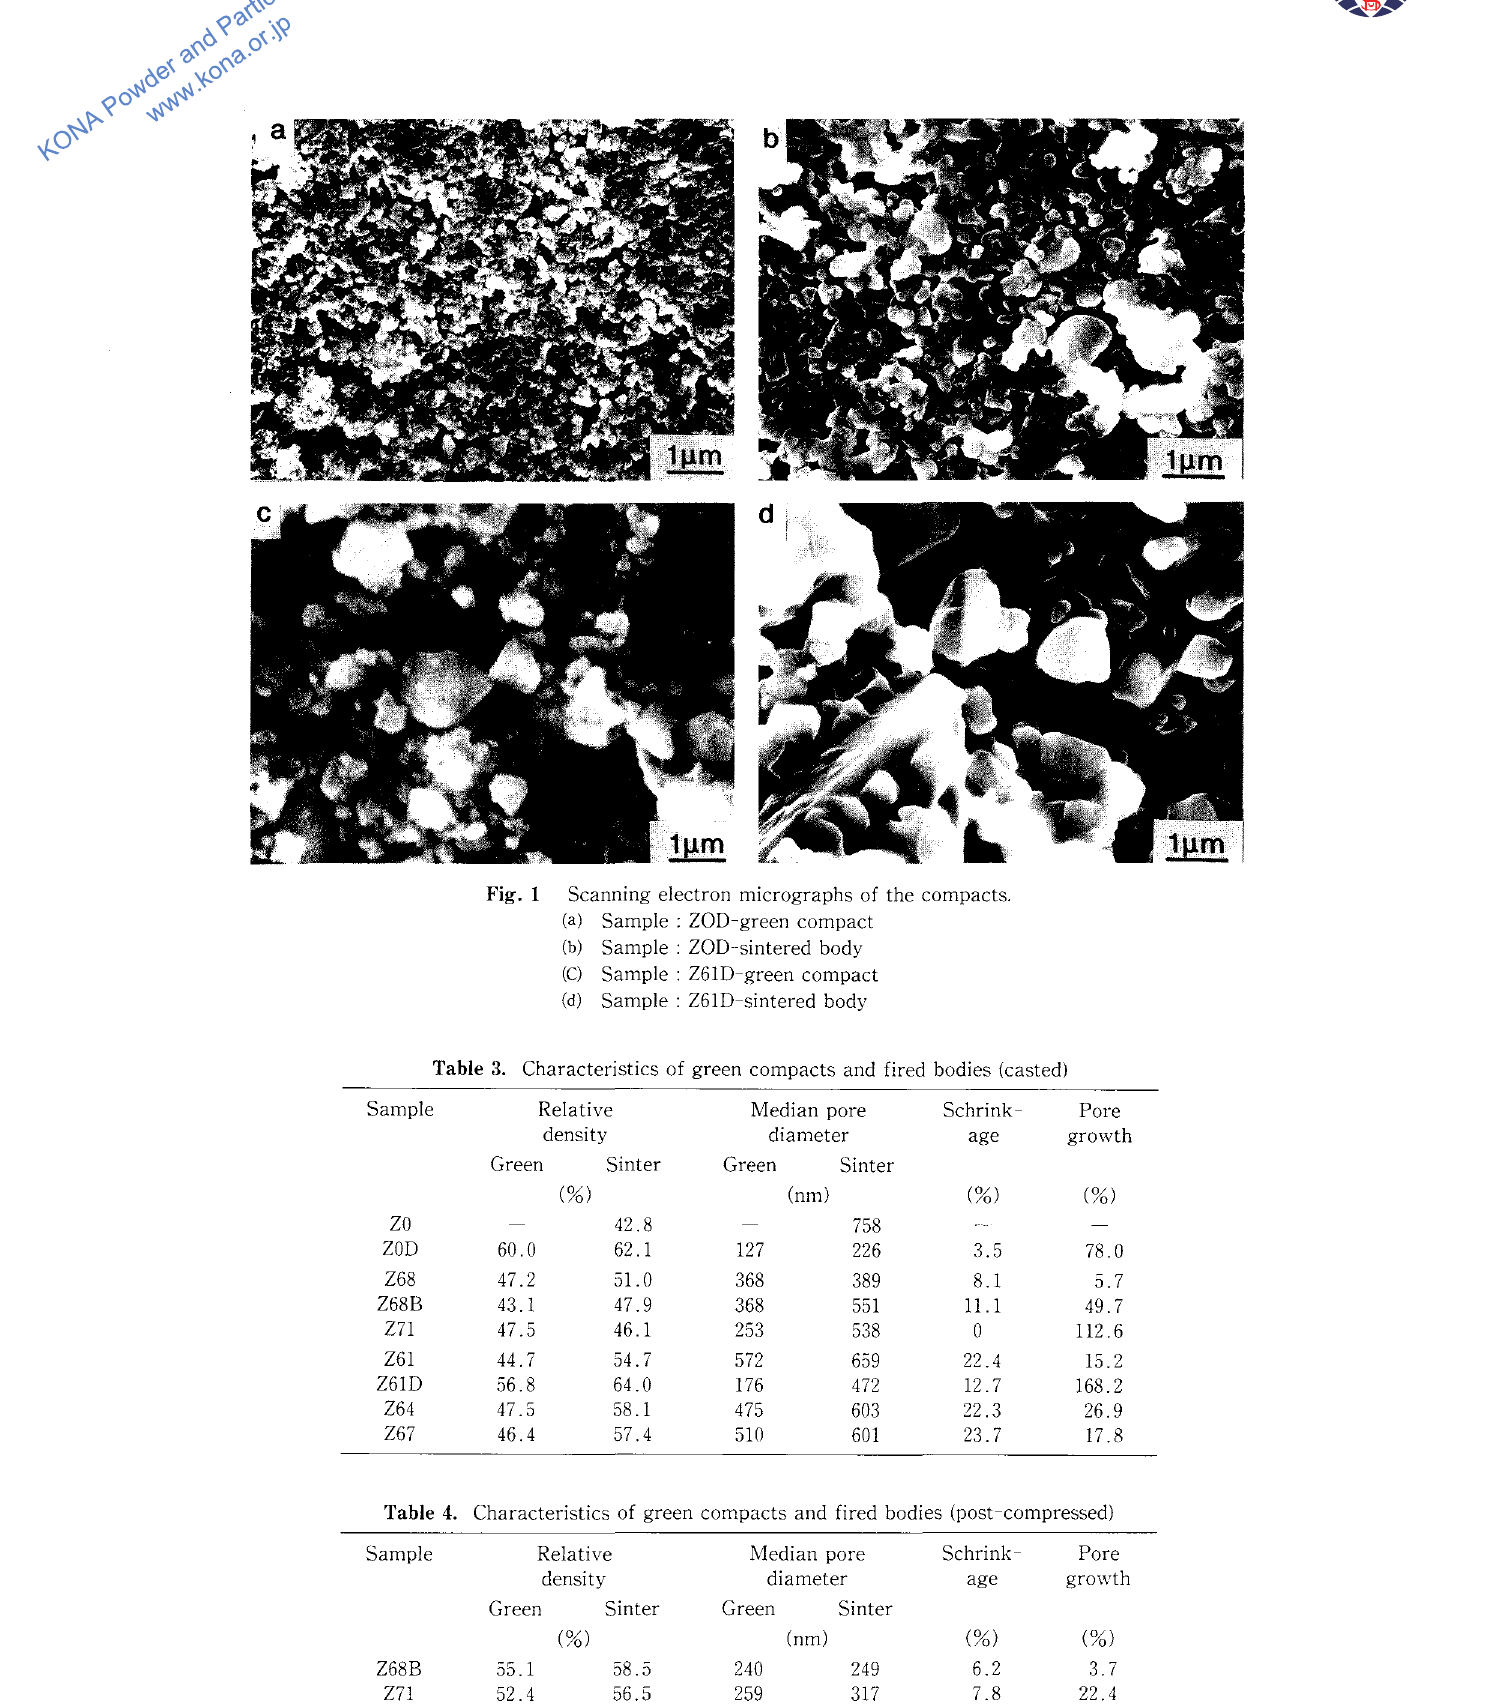
Table 4. Characteristics of green compacts and fired bodies